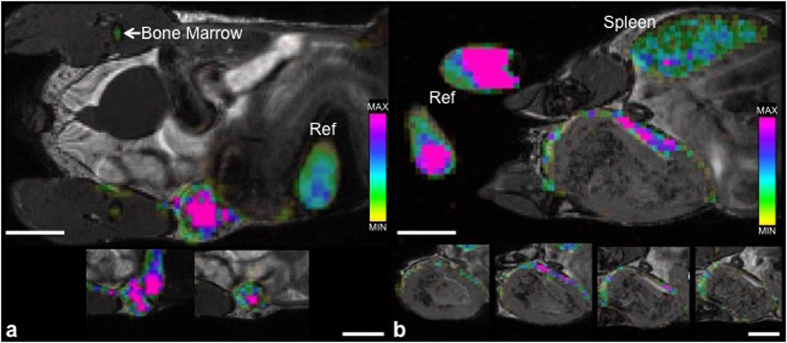
19F-based MRI cell tracking.bSSFP images of mammary fat pad tumors acquired 48 hours post PFC administration. (a) 4 days post 4T1 cancer cell injection: 19F signal is detected throughout the entire tumor with a higher density visualized within the center of the tumor (pink) when compared to the periphery. (b) 3 weeks post 4T1 cancer cell injection: 19F signal is detected, heterogeneous in density, only along the periphery of the tumor. Cropped images that are placed below each of the main images show the adjacent image slices (1 mm) containing 19F signal. The color bar demonstrates range of 19F spins. 19F signal is also detected in reference tubes (ref), bone marrow and spleen. Scale bars represent 5 mm.